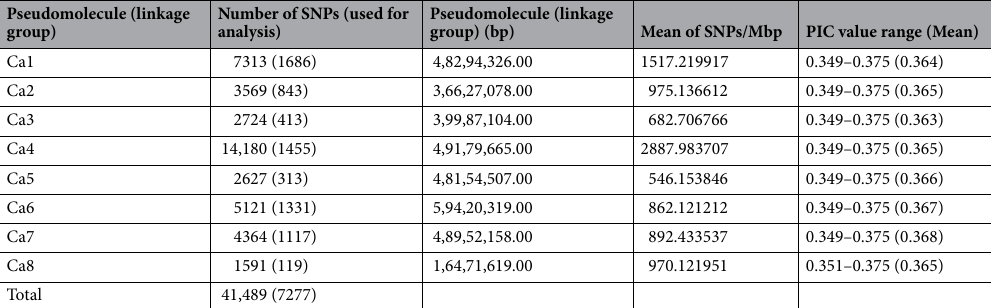
Pseudomolecule (linkage group)